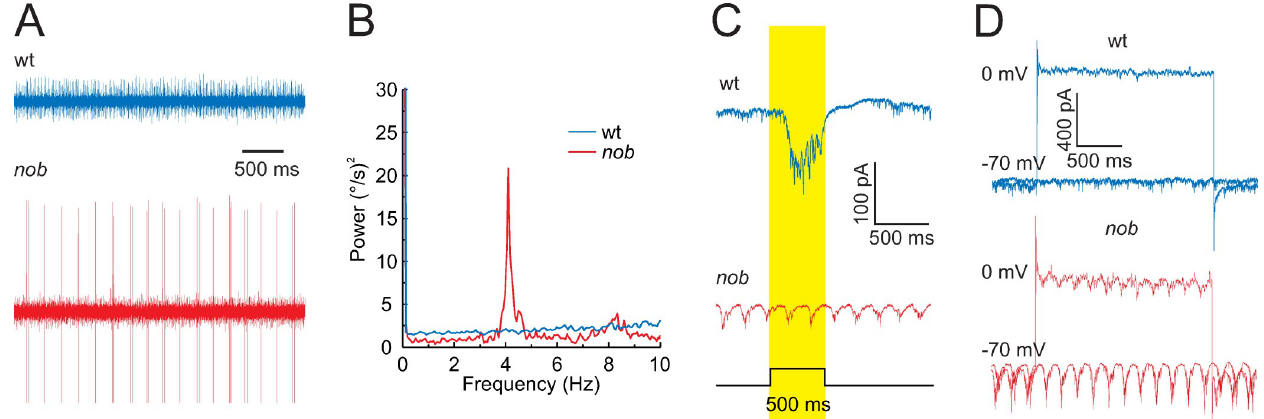
Fig 2. nob mice GC oscillate. (A) Optic nerve recordings of spontaneous GC spiking activity in wt and nob mice after 30 min of dark adaptation. The spontaneous activity of nob GCs shows oscillatory spiking patterns with a mean frequency of 4.79 ± 0.13 Hz ( n = 46 isolated units). (B) In this example, the GC fundamental frequency is 4 Hz. (C) GFP-positive cells in wt/SPIG1 + mice show an increased inward current during a light flash, e.g., an ON response (blue trace). In nob /SPIG1 + mice, GFP-positive GCs lack a light-evoked inward current and show oscillating inward currents. (D) Inhibitory and excitatory currents in GFP-positive wt/SPIG1 + (blue) and nob /SPIG1 + (red) GCs recorded under voltage-clamp conditions (holding potential: 0 and − 70 mV, respectively). In nob mice, both excitatory and inhibitory inputs oscillated with a mean frequency of 5.10 ± 0.22 Hz ( n = 36) and 4.50 ± 0.38 Hz ( n = 8), respectively. The data underlying this figure can be found at https://figshare.com/account/home#/projects/65990. GC, ganglion cell; GFP, green fluorescent protein; SPIG1, SPARC-related protein-containing immunoglobulin domains 1; wt, wild type.